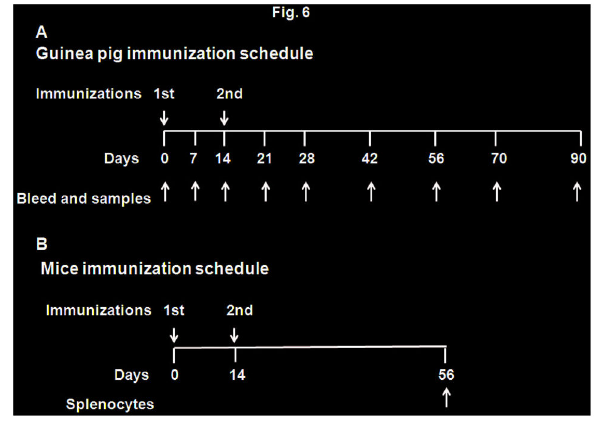
Figure 6. Immunization